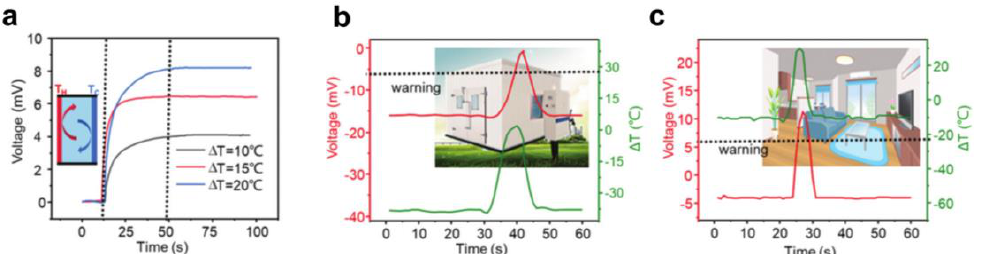
Figure 16. Application demonstration of self-powered temperature monitoring using the PVA/GL thermogalvanic hydrogel. ( a ) The response time of the H-window. Voltage response and DT (Tin – Tout) of a refrigeration storage unit ( b ) and house ( c ). (Reproduced with permission from [121]. Copyright 2022 Royal Society of Chemistry).